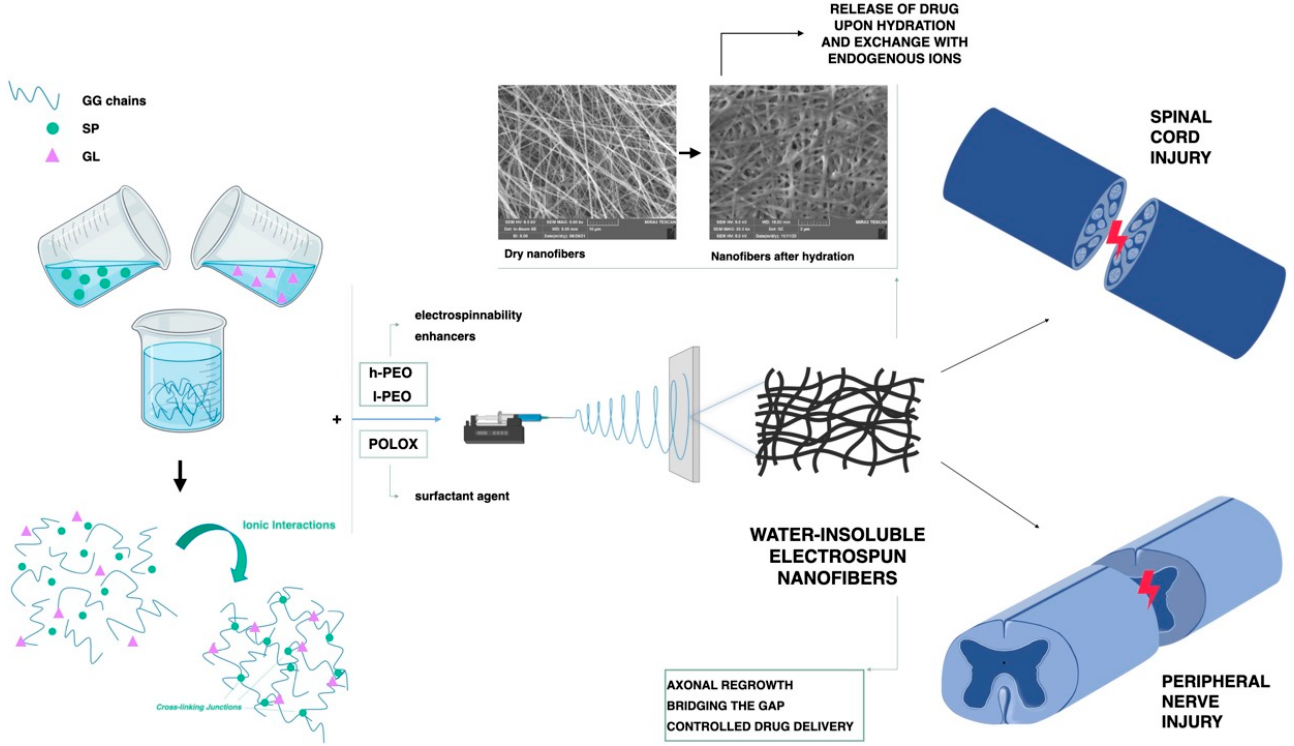
Figure 7. Representative scheme of preparation of GG-based nanofibers containing gelatin and SP developed by Vigani and coworkers for nervous tissue injuries [88].